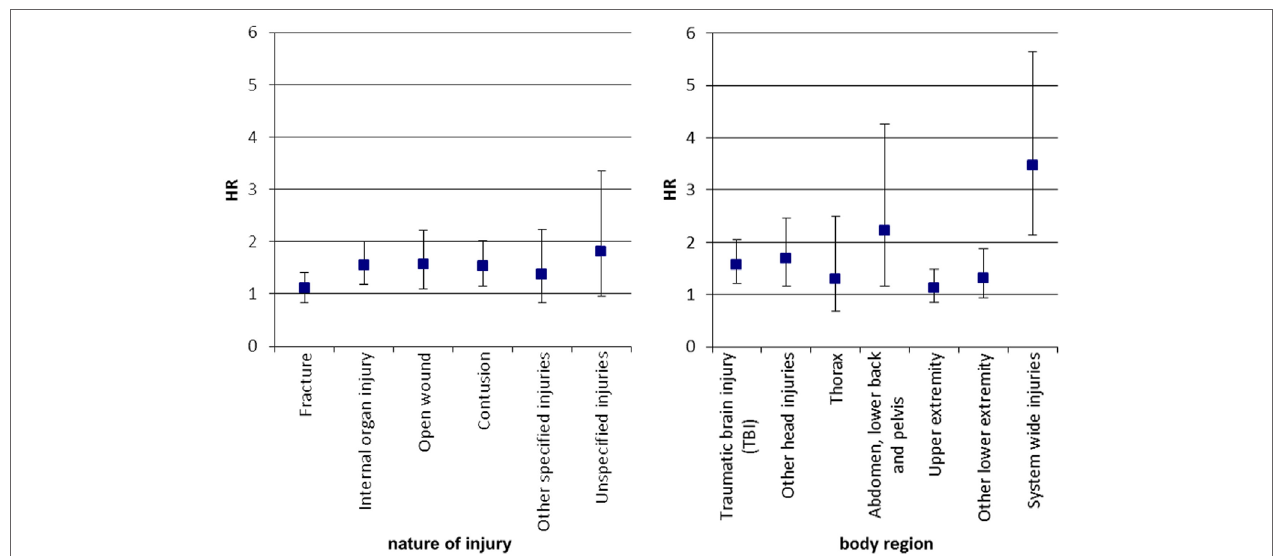
FigUre 2 | Adjusted hazard ratio of hospitalization with injury diagnoses for children with ADHD versus those without*. *Adjusted for age at hospitalization, and sex; only injury categories with at least 150 events were analyzed. Note: cox regression analysis, HR, hazard ratio, Whiskers indicate 95% confidence